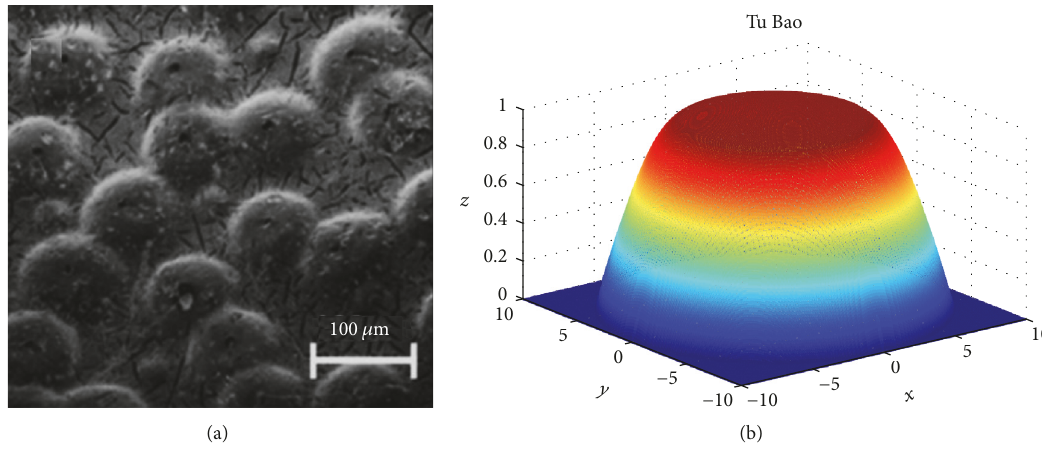
Figure 1: The convex nonsmooth surface of the dung